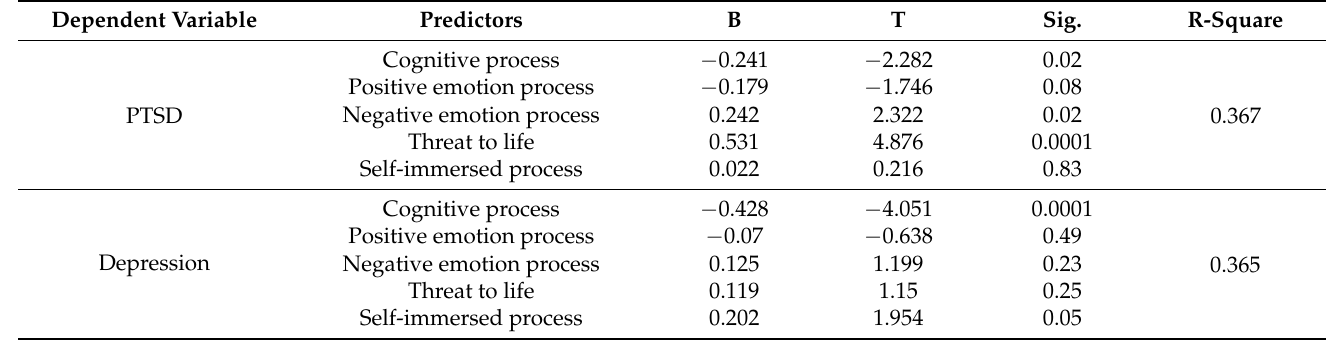
Table 4. Multiple regression analyses with the predictors of reduced PTSD and